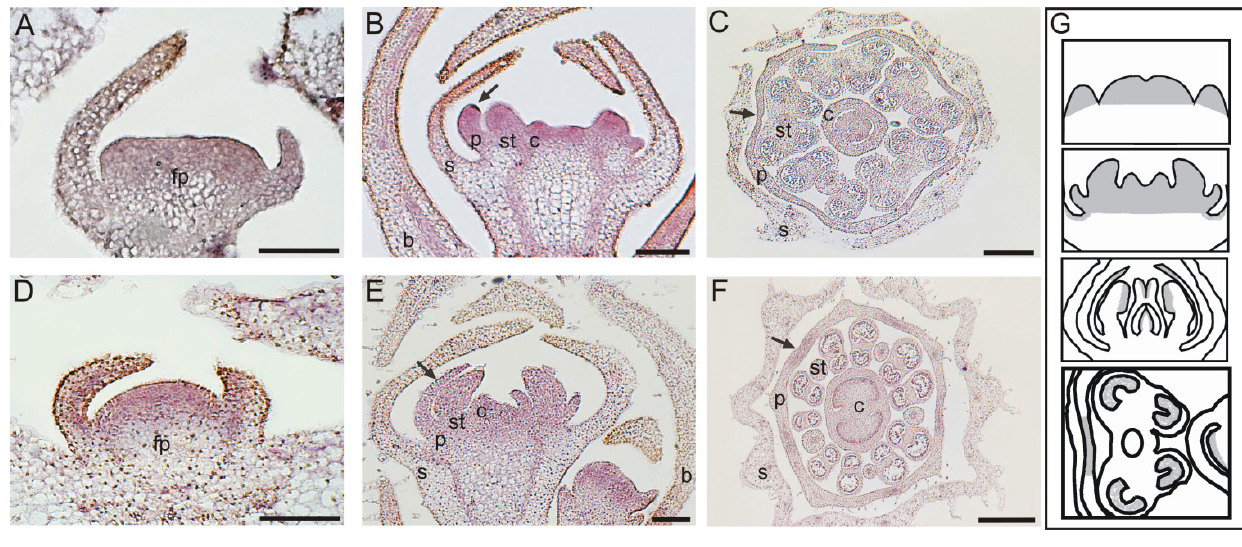
Figure 4. Gene expression analysis using in situ hybridization. The hybridization signal is detected as a purple precipitate. ( A – C ) Petunia inflata floral buds, A and B : longitudinal section of floral primordium, C : cross-section of late-developing stage; ( D – F ) Petunia axillaris floral buds, D and E : longitudinal section of floral primordium, F : cross section of late developmental stage of P. axillaris floral buds; ( G ) Schematic representation of gene expression pattern during flower development. The floral organ identities in A – F are as follows: fp, floral primordium; b, bract; s, sepal; p, petal; st, stamen; and ca, carpel. The arrow indicates the expression in petals. Bars correspond to 200